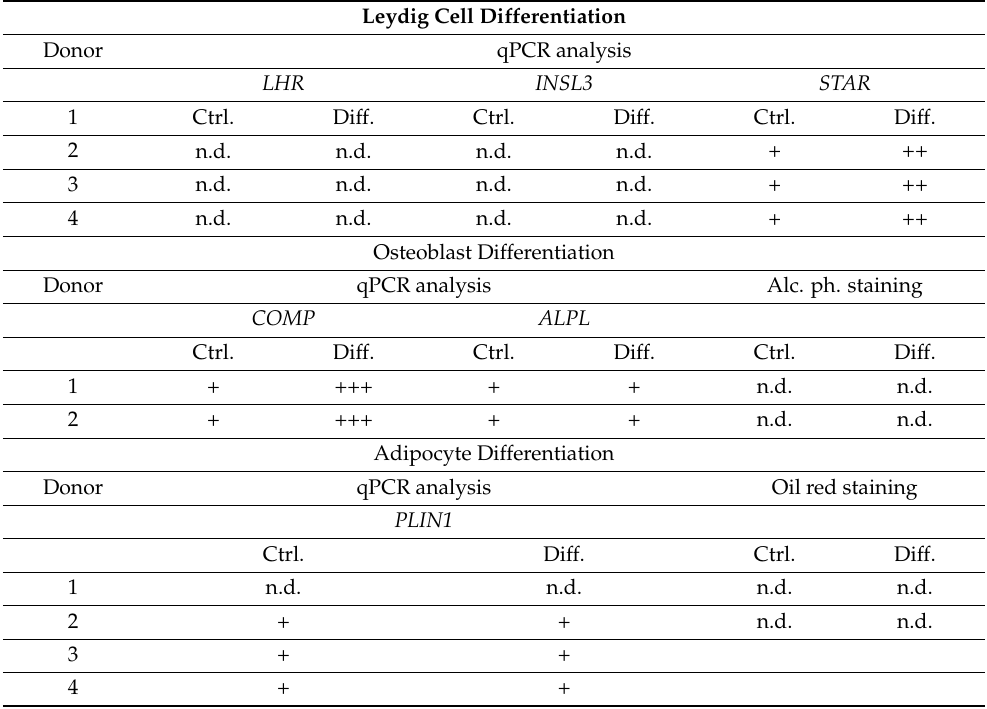
Table A4. Summary of differentiation studies. Additional HTPCs (from 2 to 4 donors) were treated as described in Materials and Methods and analyzed for Leydig cell-, osteoblast- and adipocyte-markers (Ctrl. = control group; Diff. = respective differentiation medium; n.d. = transcript not detectable;